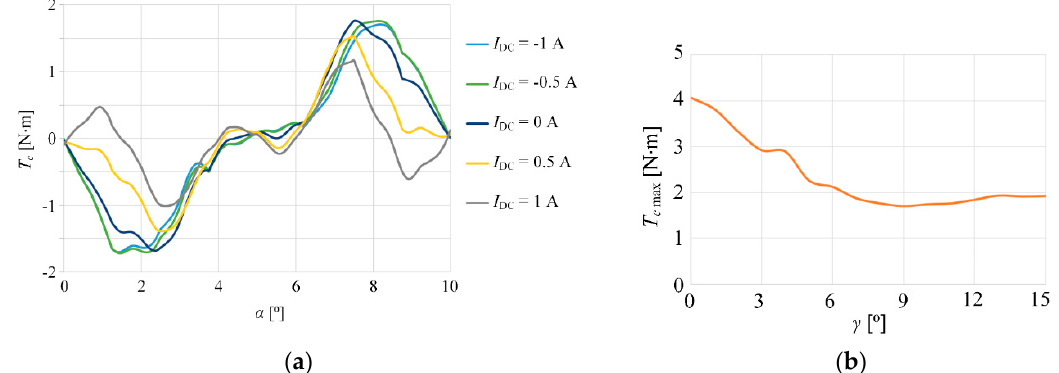
Figure 17. ( a ) Cogging torque waveforms for a machine with permanent magnets on one part of the rotor as a function of the current in the excitation coil (in kilo ampere-turns); ( b ) Maximum values of the cogging torque for a machine with permanent magnets on both parts of the rotor as a function of the angle γ , in a no-load excitation coil state [56,57].